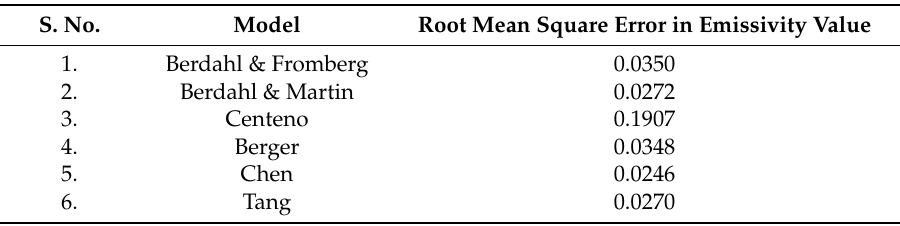
Figure 9. Comparison of different models for sky emissivity calculation with the experimental data. Table 5. Mean error for different sky emissivity models.